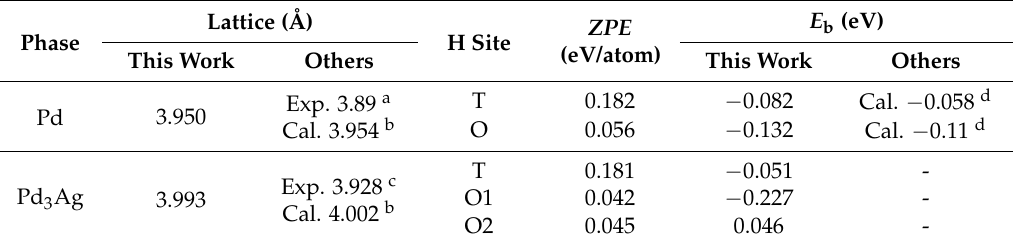
Table 1. Lattice constants ( a ), zero-point energy of hydrogen ( ZPE ), binding energies ( E b ) of pure Pd and Pd 3 Ag phases. The corresponding experimental and calculated data in the literature are also listed for comparison